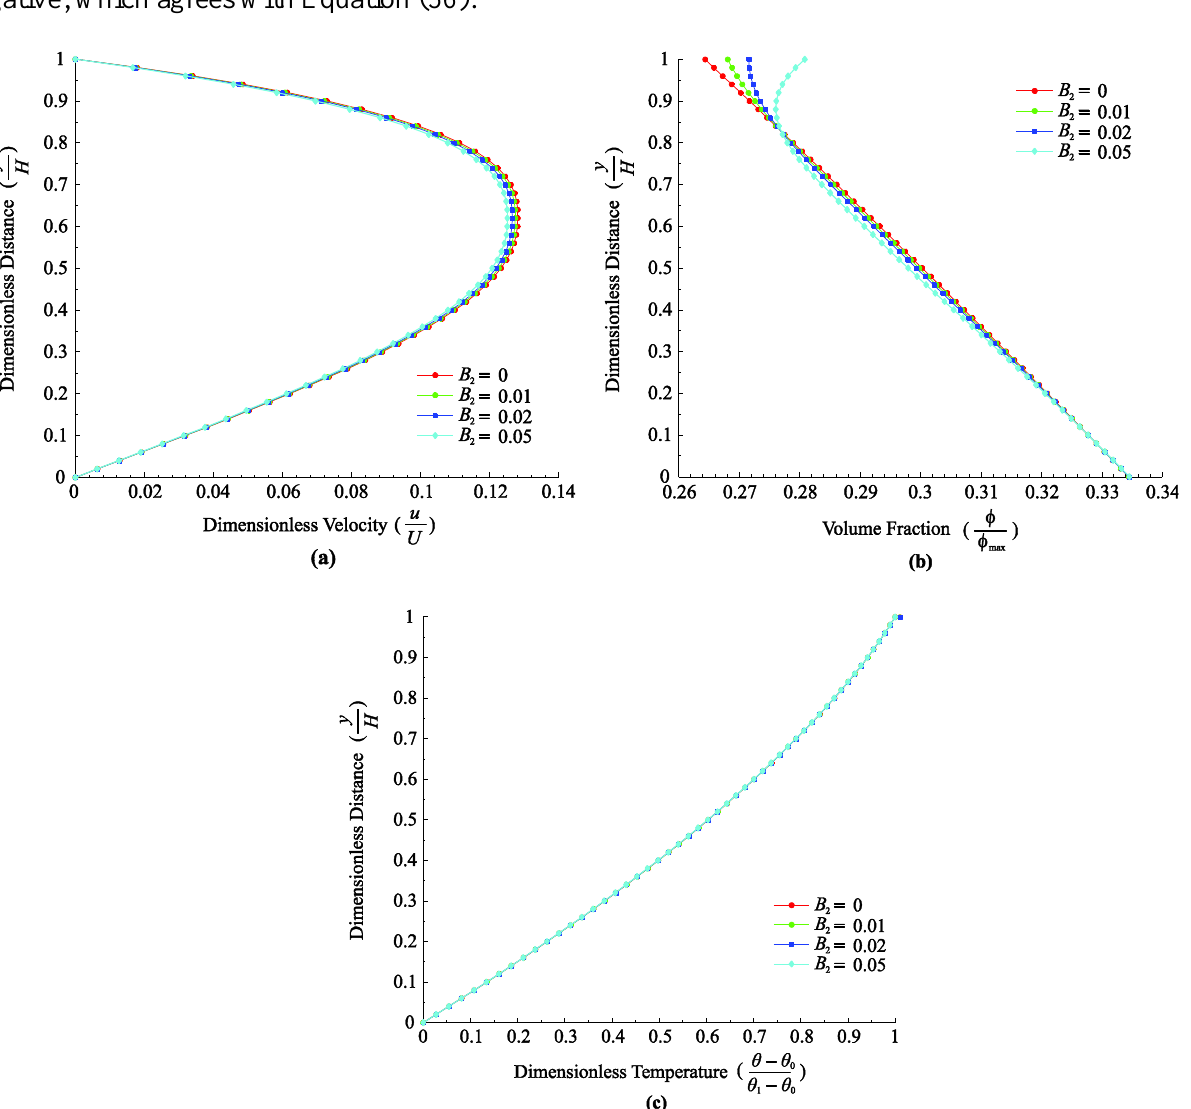
on the dimensionless velocity distribution. ( b ) Effect of 𝐵 on the 2 2 on the temperature distribution. 2 = −2, 𝐵 = 10, 𝐵 = 0.1, 𝑇 = 1.5, 𝑁 = 0.3, 𝑅 ~𝑅 = −0.1, 0.02, 1 3 4 1 7